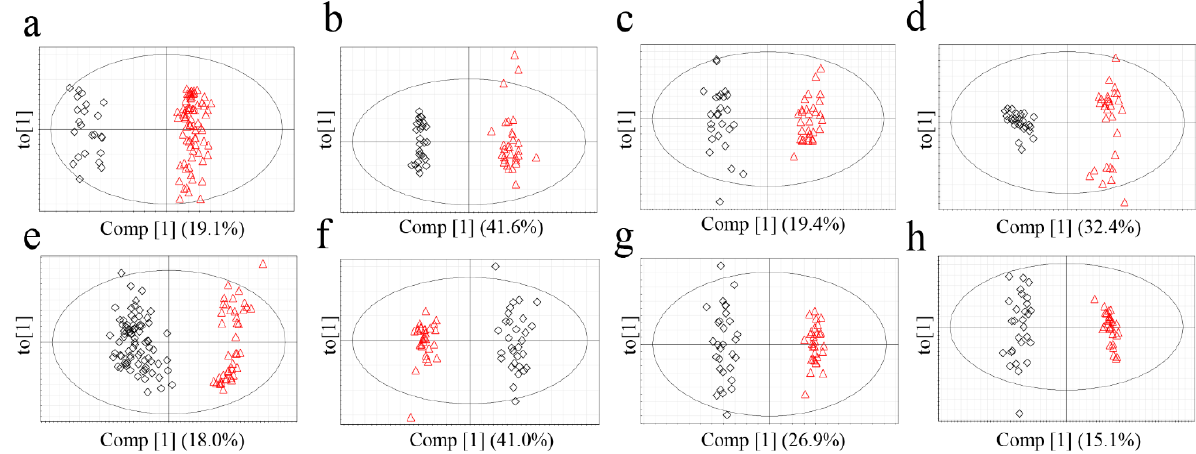
Figure 4. OPLS-DA score plots of G. elata (FT-NIR; a , 1 H-NMR; b , GC-MS; c , LC-MS; d ) and R. glutinosa (FT-NIR; e , 1 H-NMR; f , GC-MS; g , LC-MS; h ). Red triangles for Chinese samples; black diamonds for Korean